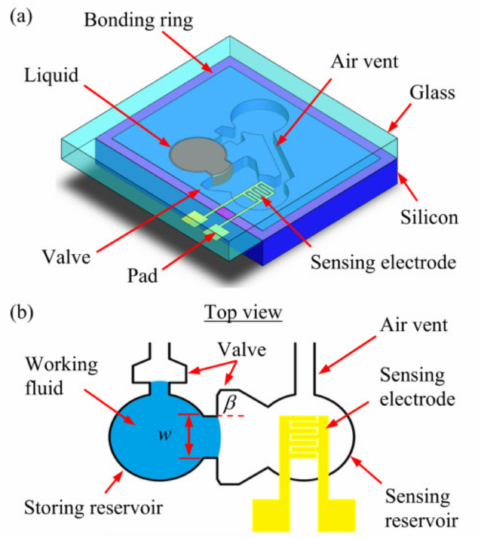
Figure 10. Schematics of the proposed microfluidic system design: ( a ) the S-A device and ( b ) top view of the